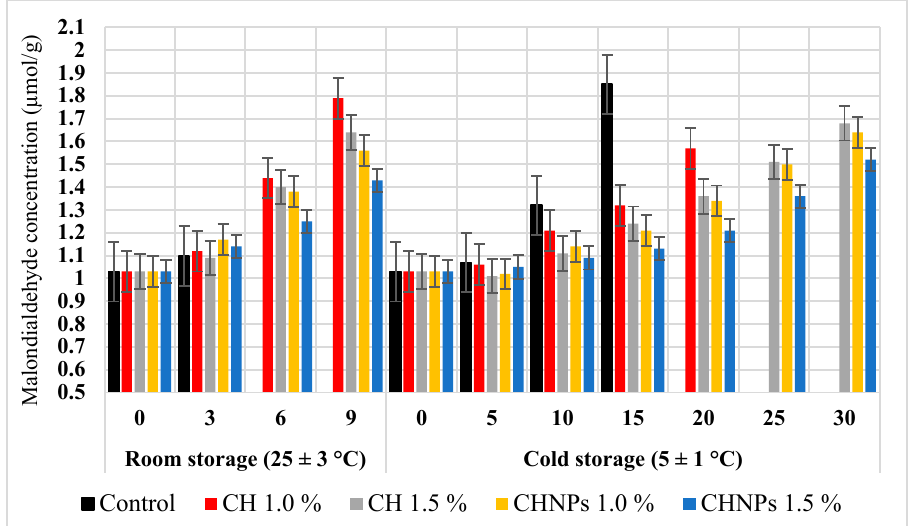
Figure 4. Malondialdehyde concentration (µmol g − 1 FW) during storage.